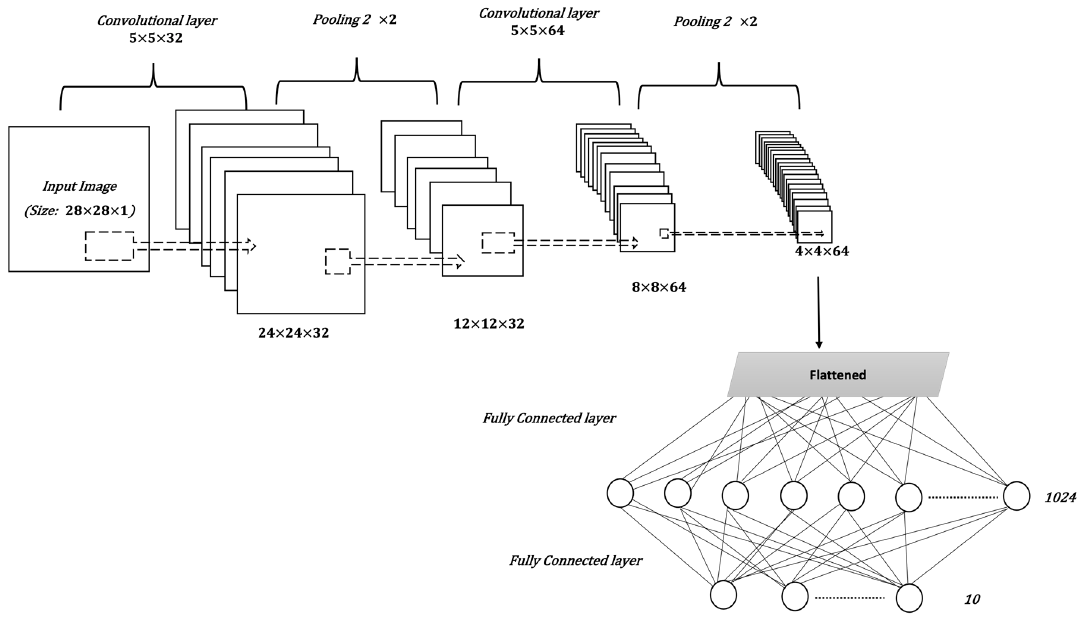
Figure 3. The general structure of a CNN